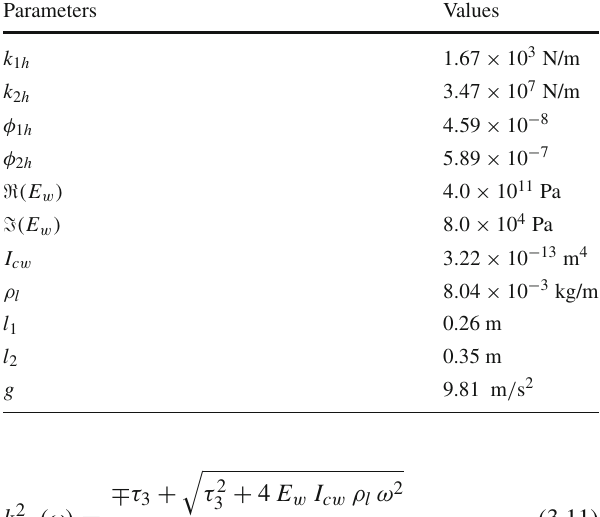
Table 2 The values of the horizontal, complex spring constants in KAGRA and related material parameters appearing implicitly in Eq. (3.9) taken from [35]. See also main text for more